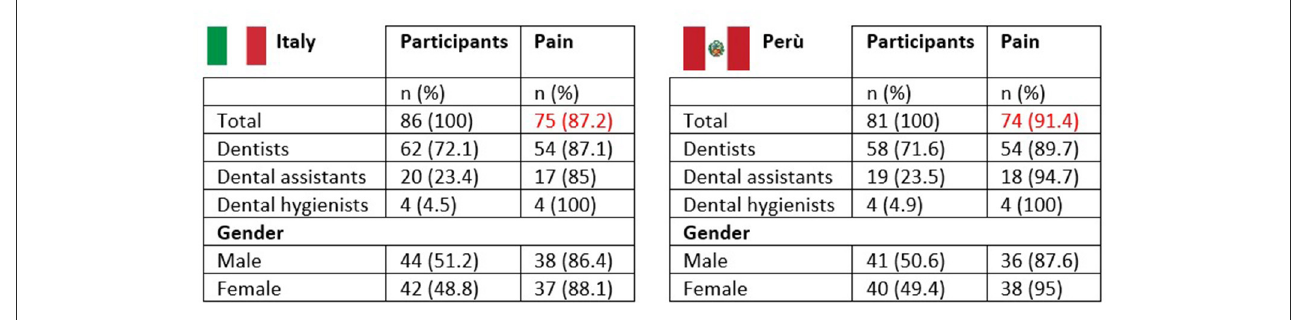
FIGURE6 Percentage of dentists who complain about musculoskeletal pain.